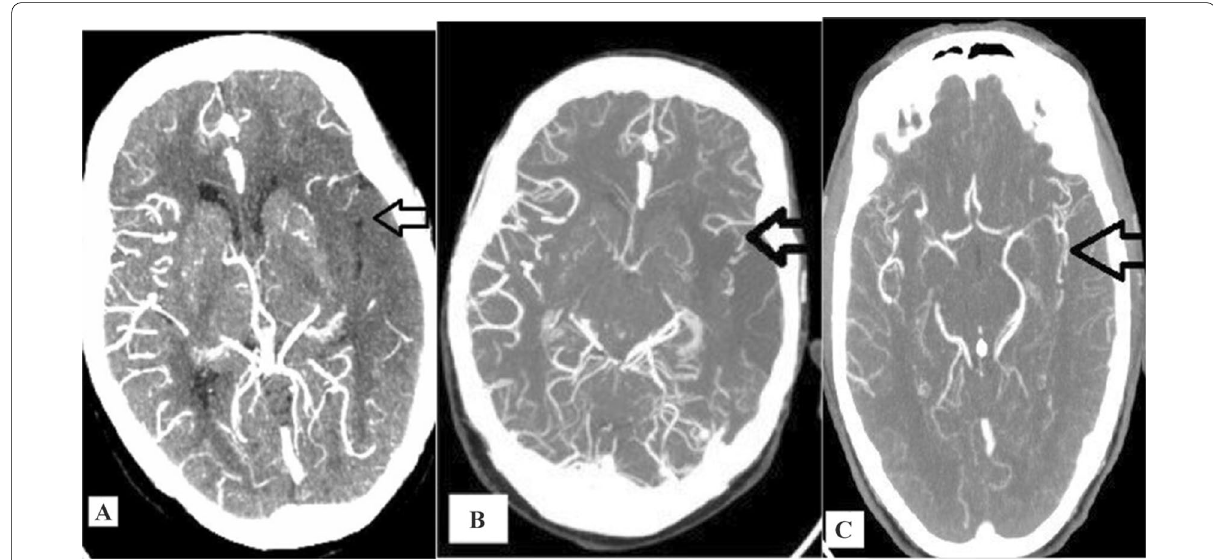
Fig. 1 Miteff system. A Contrast opacification is seen merely in the distal superficial branches. B Vessels can be seen at the Sylvian fissure. C Major vessels are reconstituted distal to the